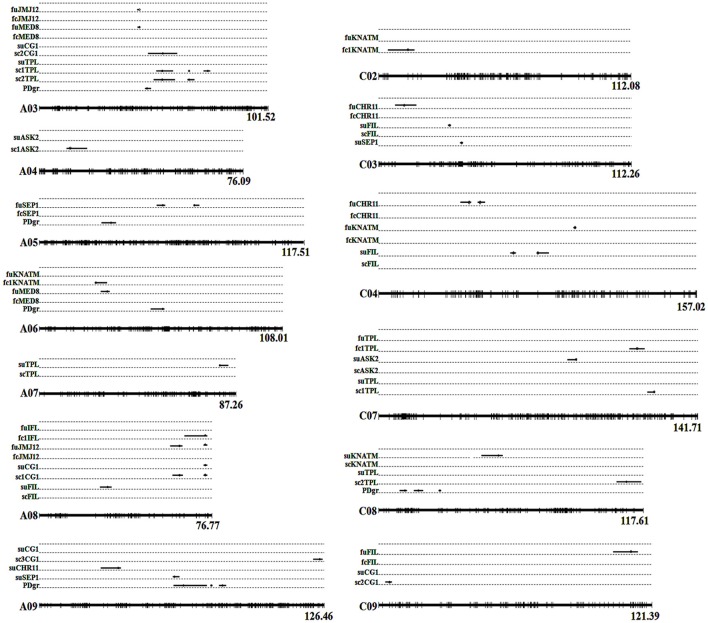
Alignments between unconditional and conditional eQTLs of TG expression levels in two environments. Whole linkage groups are represented by black lines labeled with molecular markers (short vertical bars) on the bottom. The Arabic numerals listed on the right side indicate the lengths of the linkage groups. The TGs' unconditional and conditional expression levels are listed on the left side. “fu” represents the TG's unconditional expression level, while “fc” represents the TG's conditional expression level in the first environment. “su” represents the TG's unconditional expression level, while “sc” represents the TG's conditional expression level in the second environment. The black lines on the linkage groups show the QTL confidence interval and the circles indicate the peak position. Detailed information of eQTLs is shown in Tables 4, 5. PDgr is the acronym of petalous degree. fcCHR11: CHR11|PLP, CHR11|MED8; fcFIL: FIL|ASK2, FIL|SEP1; fc1IFL: IFL|ASK2; fcKNATM: KNATM|ASK2, KNATM|IFL; fcJMJ12: JMJ12|AS2, JMJ12|MED8, JMJ12|CG1; fc1KNATM: KNATM|IFL; fcMED8: MED8|CHR11, MED8|JMJ12; fcSEP1: SEP1|FIL; fc1TPL: TPL|ASK2×SEP2. scASK2: ASK2|KANT, ASK2|FILxKNATM; sc1ASK2: ASK2|FIL×KNATM; scCG1: CG1|JMJ12, CG1|UFO, CG1|FIL×TPL, CG1|IFL×SEP2; sc1CG1: CG1|FIL×TPL; sc2CG1: CG1|IFL×SEP2; sc3CG1: CG1|UFO; scFIL: FIL|ASK2; scKNATM: KNATM|ASK2; scTPL: TPL|IFL×SEP2, TPL|KNATM×SEP2; sc1TPL: TPL|IFL×SEP2; sc2TPL: TPL|KNATM×SEP2.